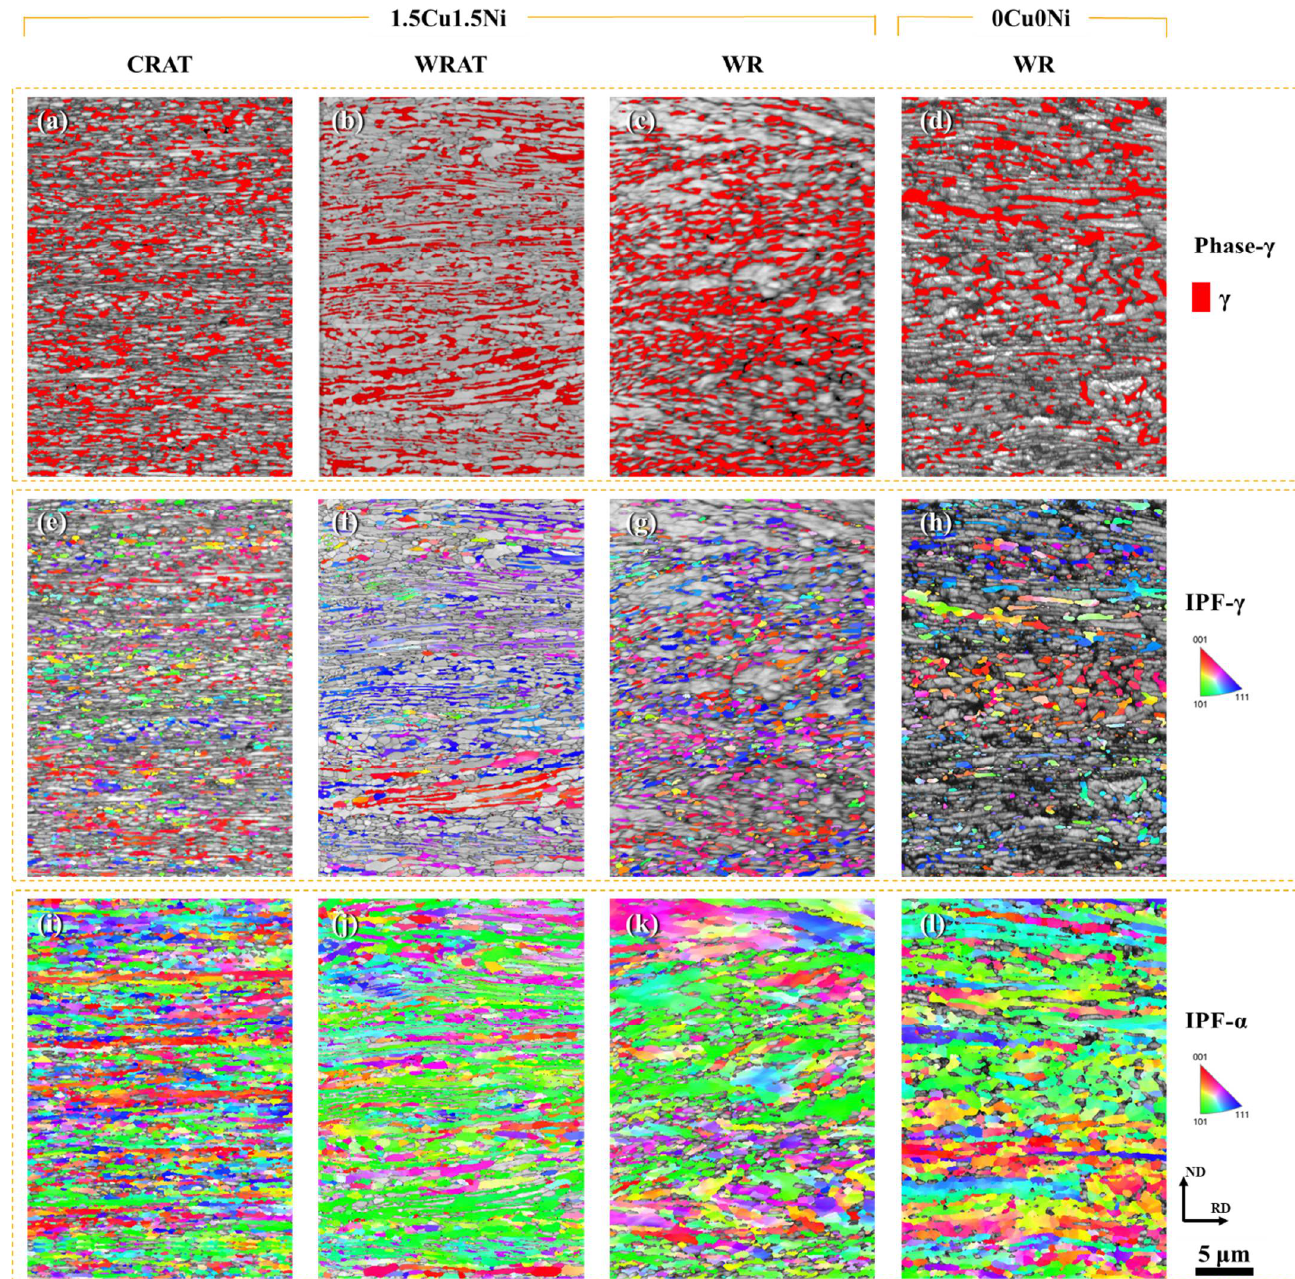
Figure 6. EBSD analysis of the investigated specimens. ( a – d ) Phase maps of austenite (in red) overlapped with IQ maps of ferrite; ( e – h ) inverse pole figure (IPF) of austenite; ( i – l ) IPF of ferrite in the 1.5Cu1.5Ni-CRAT, 1.5Cu1.5Ni-WRAT, 1.5Cu1.5Ni-WR, and 0Cu0Ni-WR specimens,